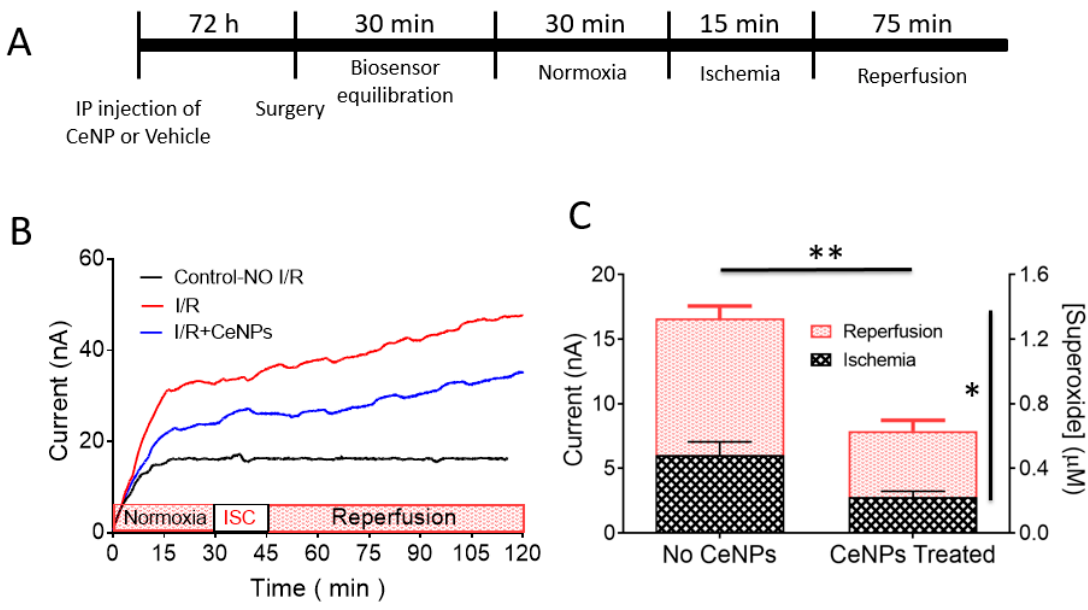
Figure 6. ( A ) Experimental timeline (not drawn to scale) for in vivo monitoring of superoxide during ischemia (right common carotid artery occlusion) and reperfusion in rats. ( B ) In vivo amperometric current–time response of the Cyt C microbiosensor showing continuous monitoring of superoxide anion radical in rat hippocampus at an applied biosensor potential of + 0.15 V vs. Ag / AgCl. Representative amperograms for the control with no ischemia (black), ischemia and reperfusion (red) and ischemia and reperfusion in the CeNPs-treated rats (blue) are displayed. Ischemia (ISC) was induced for 15 min (30–45 min time point) and followed by reperfusion for 75 min (45–120 min time point). ( C ) Quantification of superoxide levels in vivo in rat brain hippocampus during ischemia and reperfusion. Bar graphs show the contribution of superoxide during ischemia (black hatched area) and reperfusion (red hatched area) in both CeNP-treated (n = 9) and vehicle control (no CeNPs) (n = 7) animals. Values are expressed as mean ± SEM. A two-way ANOVA revealed two main e ff ects: a significant reduction (** p < 0.0001) in the total concentration of superoxide (ischemia plus reperfusion) in CeNPs-treated animals compared to controls (no CeNPs), and the SO concentration was significantly greater during reperfusion compared to ischemia (* p = 0.0015).